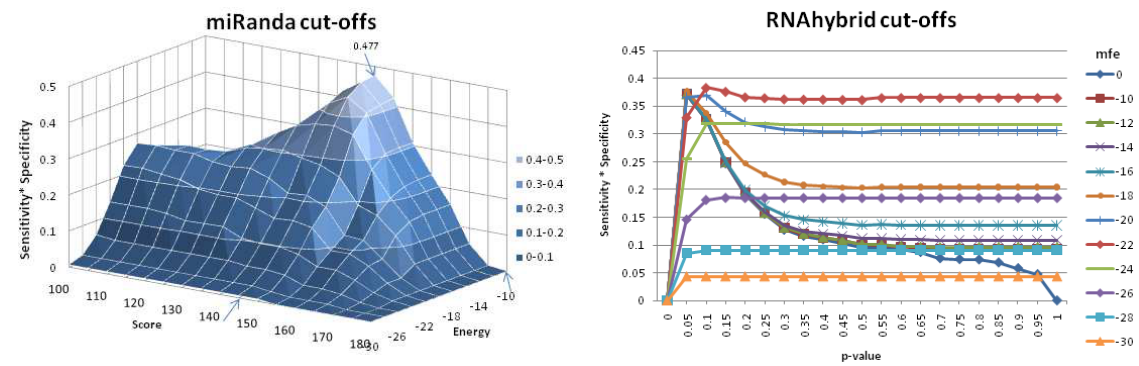
Figure 2: Filter optimizations for miRanda and RNAhyrbid. The combination of sequence score and free energy which achieves the best performance is set as thresholds for miRanda (left). The best combination of mfe and p -value is set as thresholds for RNAhybrid